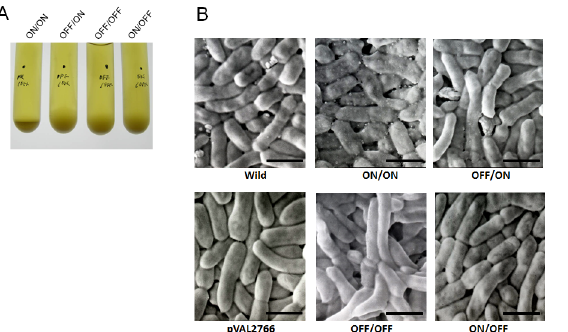
Fig 2. Orientation-specific phenotypes of BF2766 mutant B . fragilis cells with respect to IVp-I/IVp-II. (A) The four types of IVp-I/IVp-II-locked mutants were anaerobically cultured in GAM broth overnight. Each culture was mixed to homogeneity and grown in an anaerobic chamber. Periodically, cell sedimentation was visually compared. ON/ON cells sank to the bottom faster than the other three genotypes, generating a more compact cell pellet. The promoter patterns are indicated above the tubes. (B) Scanning electron micrographs of wild-type and mutant cells. Plasmid-complemented BF2766 mutant cells (pVAL2766) were also examined. The ON/ON-locked mutant produced a large number of vesicle structures on the cell surface. Bar: 2 μ